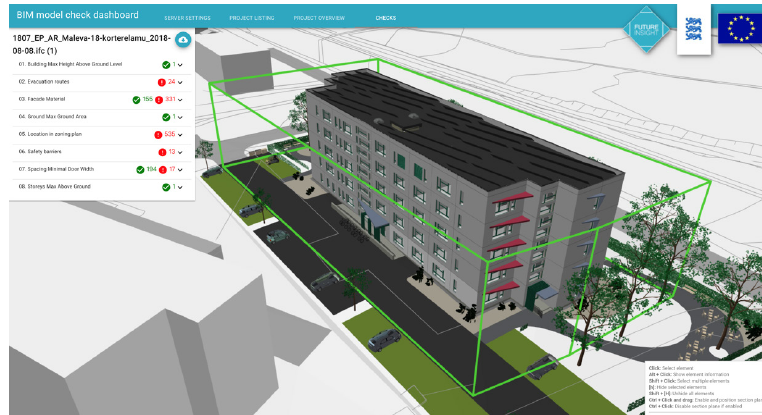
Figure 4. The interface of POC (source: Estonian Ministry of Economic Affairs and